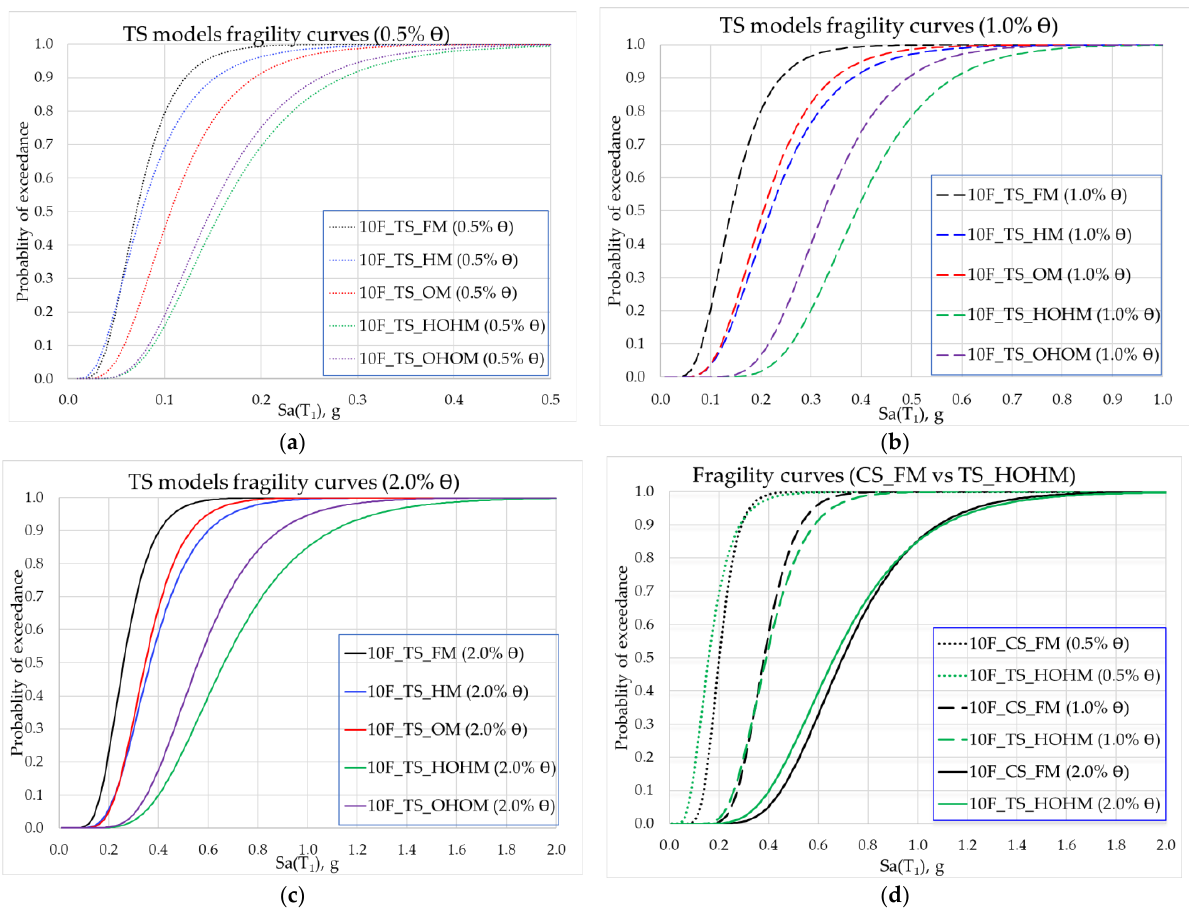
Figure 10. Fragility curves of all models: ( a ) TS (0.5%) θ , ( b ) TS (1.0%) θ, ( c ) TS (2.0%) θ, ( d )